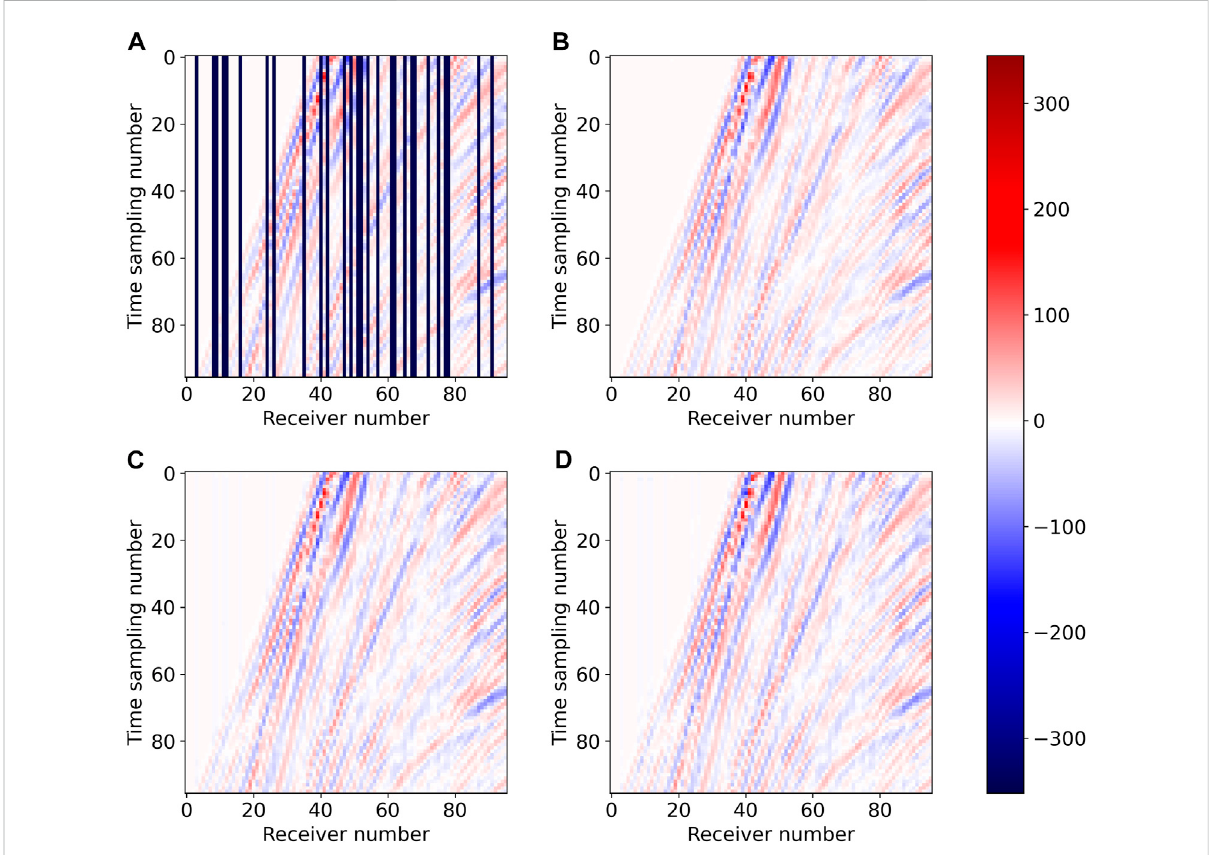
FIGURE 13 Shot slice of interpolation results on fi eld data: (A) missing traces data, (B) ground truth, (C) Unet (Chai et al., 2021), and (D)